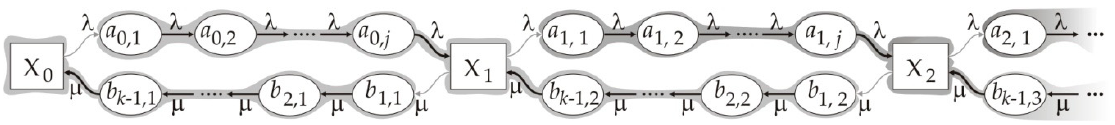
Figure 4. The principle of applying abstract hidden Markov states (HMS) in the queueing system.